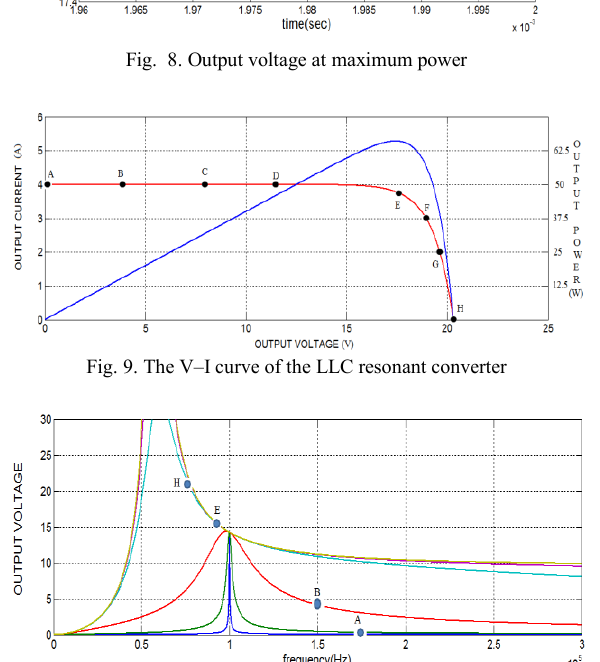
Figure 12. Switch voltage vs. duty cycle